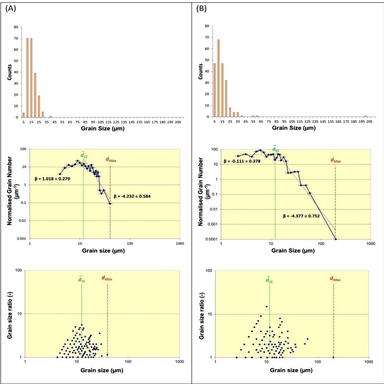
Grain size distribution plotted in lin DN/Ntot – lin , and, in log dN/dd – log d mode. A plot of Ri vs. d is also shown (bottom). Samples: A. 'as delivered', longitudinal (L) and B. 1% additional cold work with partial recrystallization at 880°C. S = 58,450 mm2.